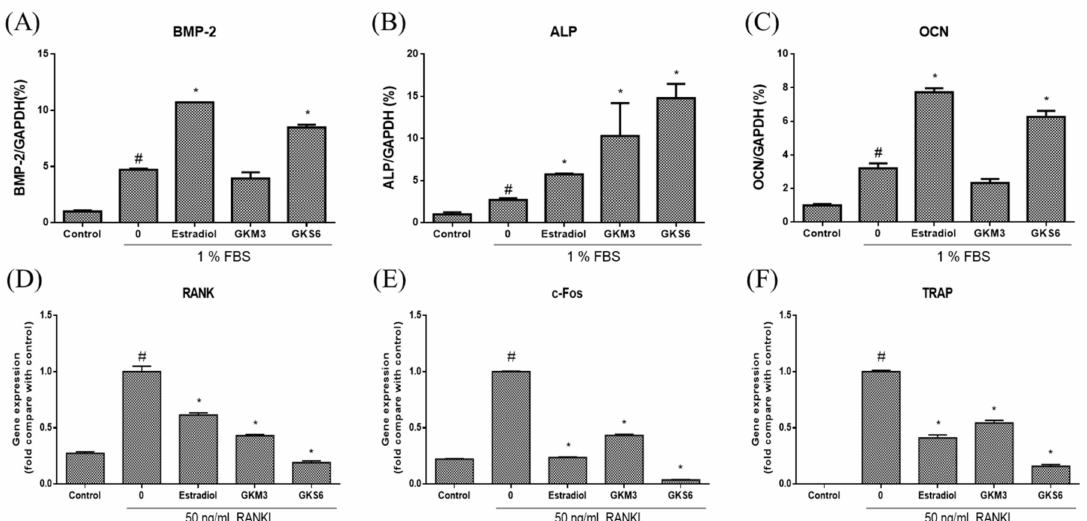
Figure 3. E ff ect of probiotics on osteoblast and osteoclast di ff erentiation. Data are presented as the mean ± SD. For osteoblast di ff erentiation, MG-63 cells were treated with estradiol, GKM3, and GKS6 in 1% FBS medium for 7 days. Gene expression of (A) bone morphogenetic protein-2 (BMP-2), (B) alkaline phosphatase (ALP), and (C) osteocalcin (OCN) on day 7 were determined by Q-PCR. For osteoclast di ff erentiation, RAW264.7 were treated with estradiol, GKM3, and GKS6 in the presence of 50 ng / mL RANKL for 7 days. Gene expression of (D) receptor activator of nuclear factor- κ B (RANK), (E) Cellular Oncogene Fos (c-Fos), and (F) tartrate-resistant acid phosphatase (TRAP) on day 7 were determined by Q-PCR. All data were normalized to GADPH. # p < 0.05 compared with control and * p < 0.05 compared with